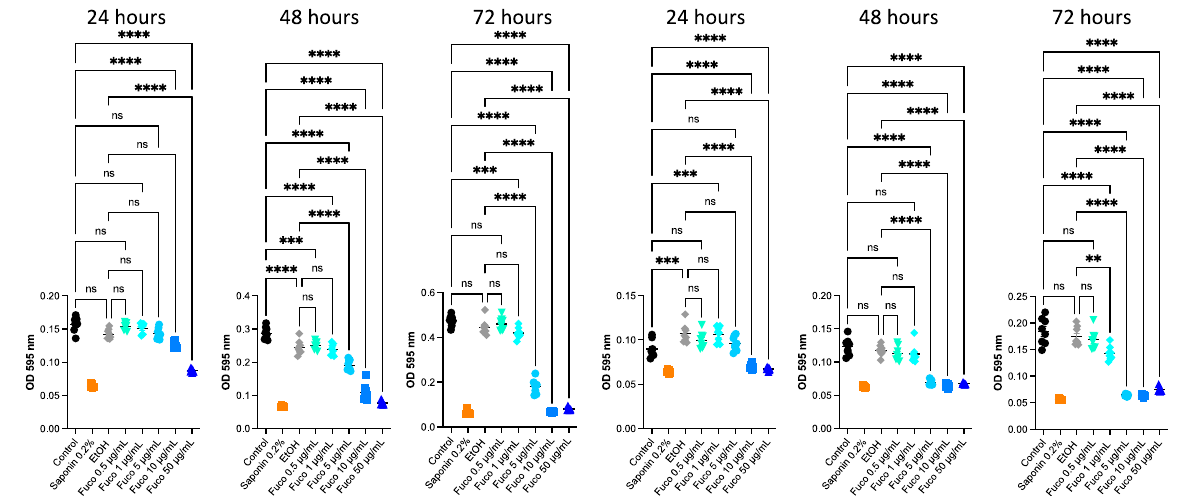
Figure 2. E ff ects of fucoxanthin pigment on PCa cell line proliferation. DU145 ( A ) and LNCaP ( B ) cells were treated with fucoxanthin (Fuco) at 0.5, 1, 5, 10, and 50 µg/mL for 24, 48 and 72 h. The proliferation rate was measured by crystal violet assay (OD 595 nm). Results are shown as mean ± SEM, one-way ANOVA, ns = not signi fi cant, ** p < 0.01, *** p < 0.001, **** p < 0.0001 ( n = 8).